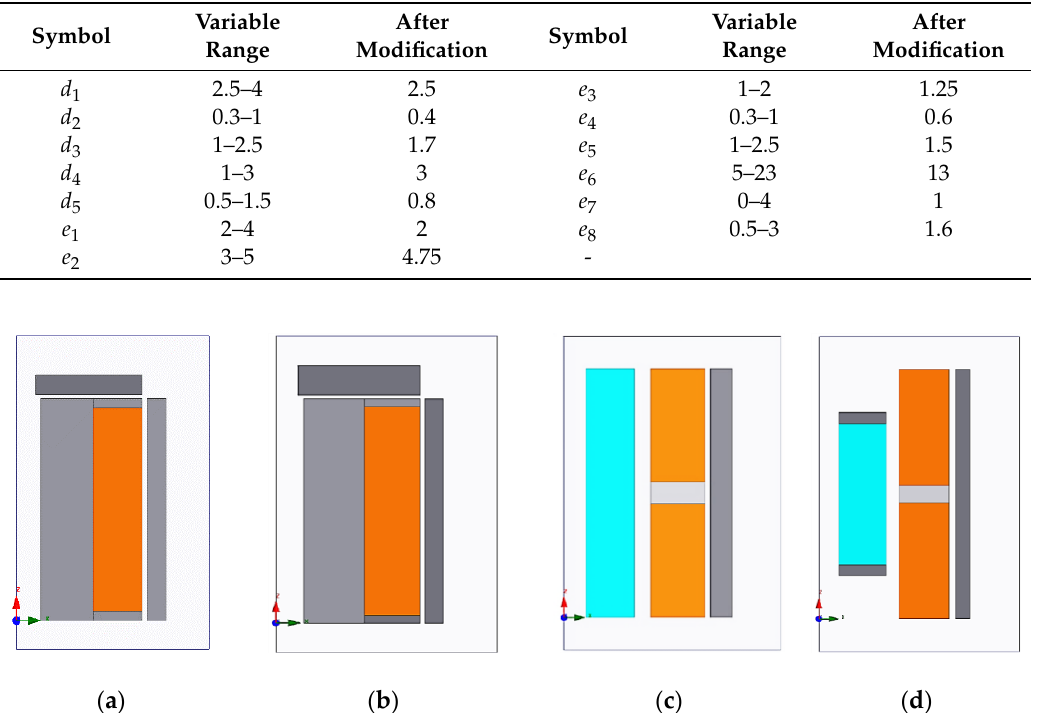
Table 3. Variable range of geometric dimensions and modified dimensions.